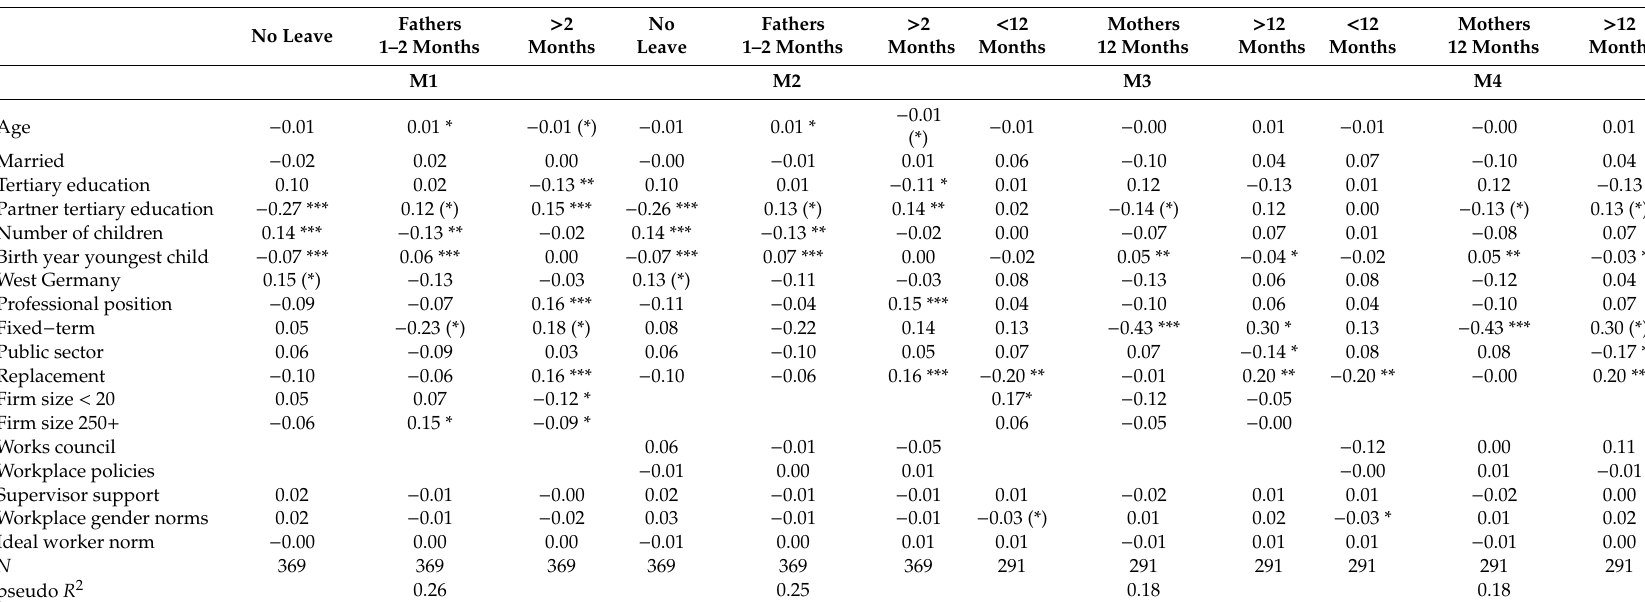
Table A5. Full model length of parental leave: multinomial logistic regressions, average marginal e ff